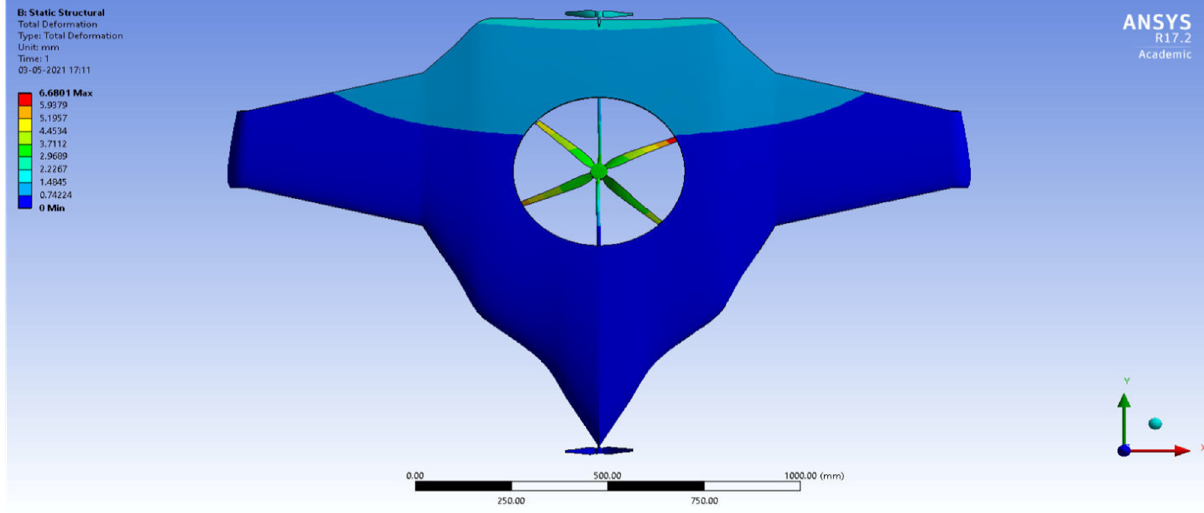
Figure 16. Total deformation.